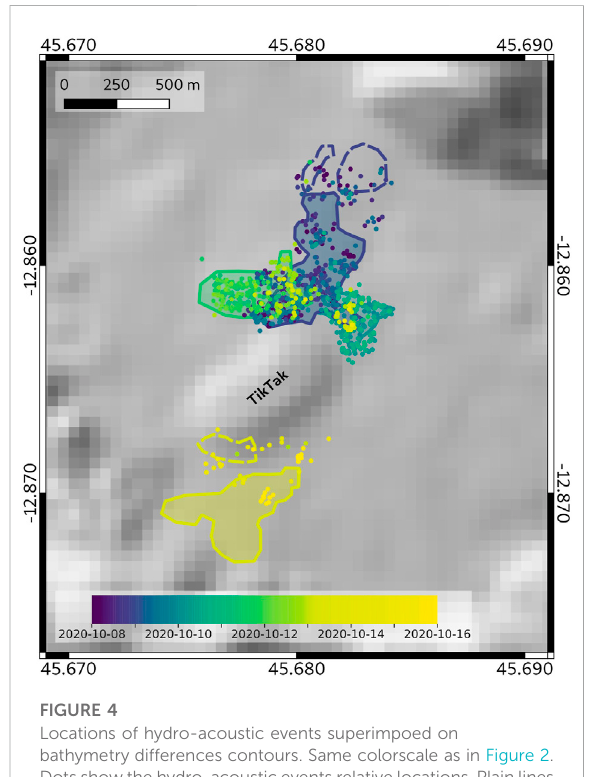
FIGURE 4 Locations of hydro-acoustic events superimpoed on bathymetry differences contours. Same colorscale as in Figure 2. Dots show the hydro-acoustic events relative locations. Plain lines contours are the outlines of reliable depth differences from Figure 2 interpreted as new lava fl ows. Dashed contours show the outlinesofquestionabledepthchanges, thatwefurthercon fi rmed as new volcanic material thanks to hydro-acoustic events relative